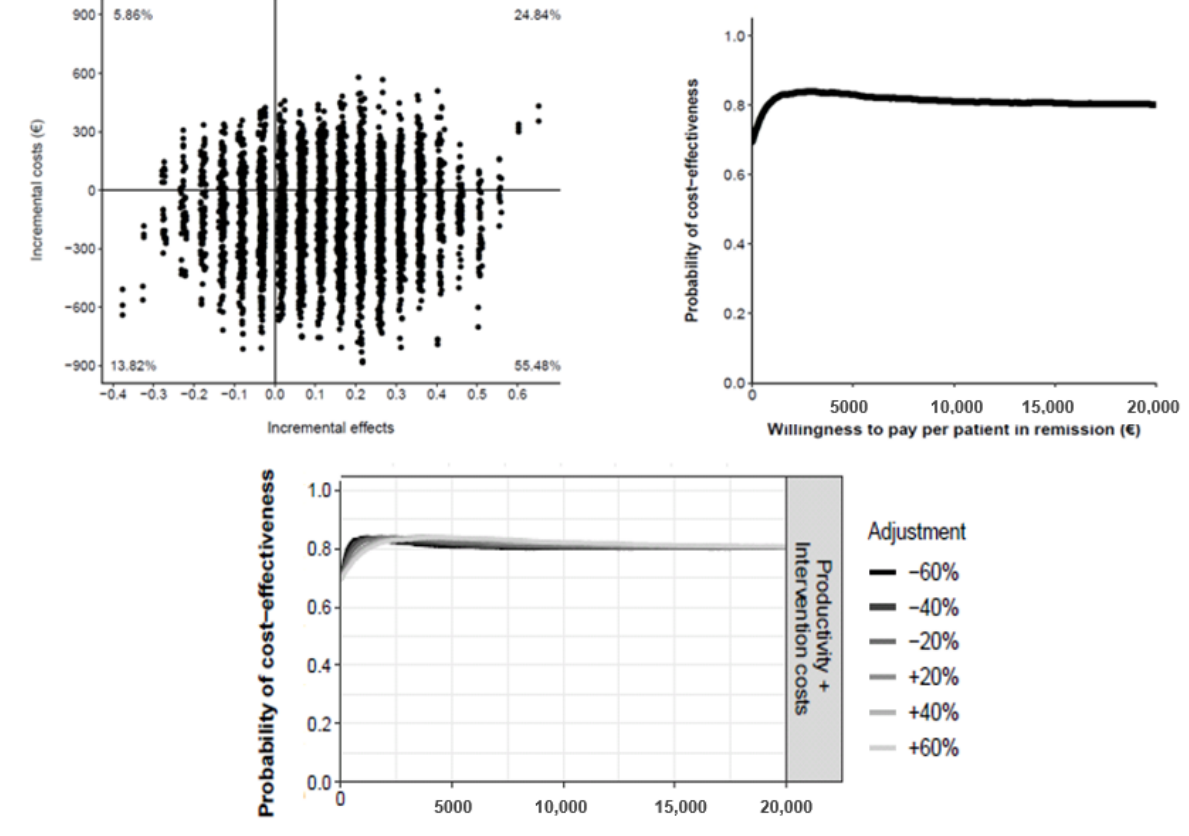
Figure 4. Cost-effectiveness plane (top left) and cost-effectiveness acceptability curve (top right) comparing Telemonitoring of Crohn’s Disease